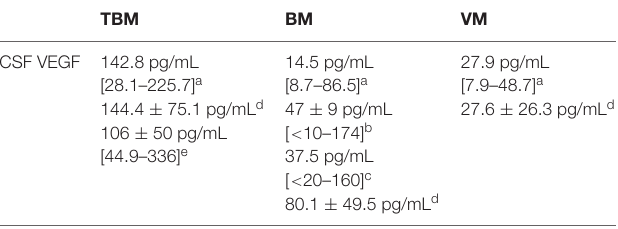
TABLE 2 | Summary of CSF VEGF concentrations in different types of